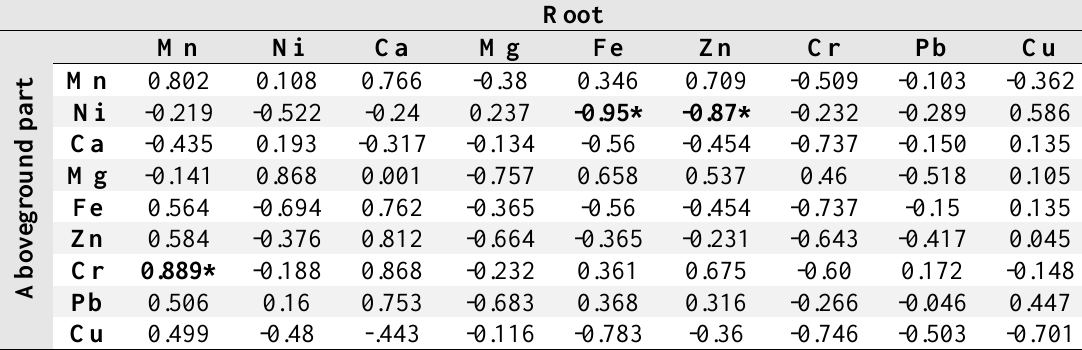
Table 4. Pearson’s Correlation of heavy metals among root and aboveground part of Rumex